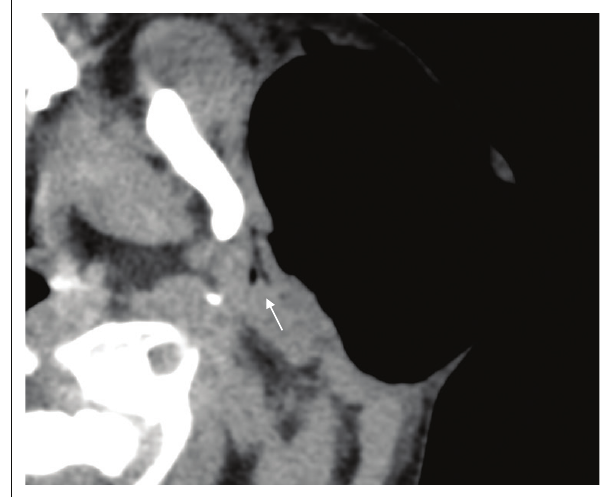
FIGURE 2: Magnified axial non-contrasted computed tomography with soft tissue window again demonstrates the gas-filled branching parotid ductal pattern (white arrow). The left parotid gland appears otherwise morphologically normal, with no features of inflammation.